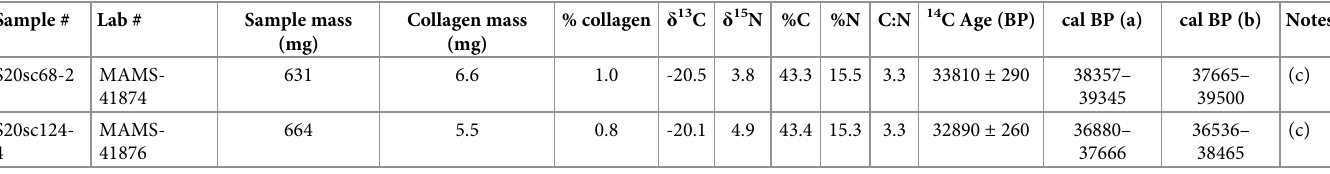
Table 8. AMS radiocarbon dating in the entrance trench: Results. Sample # Lab #